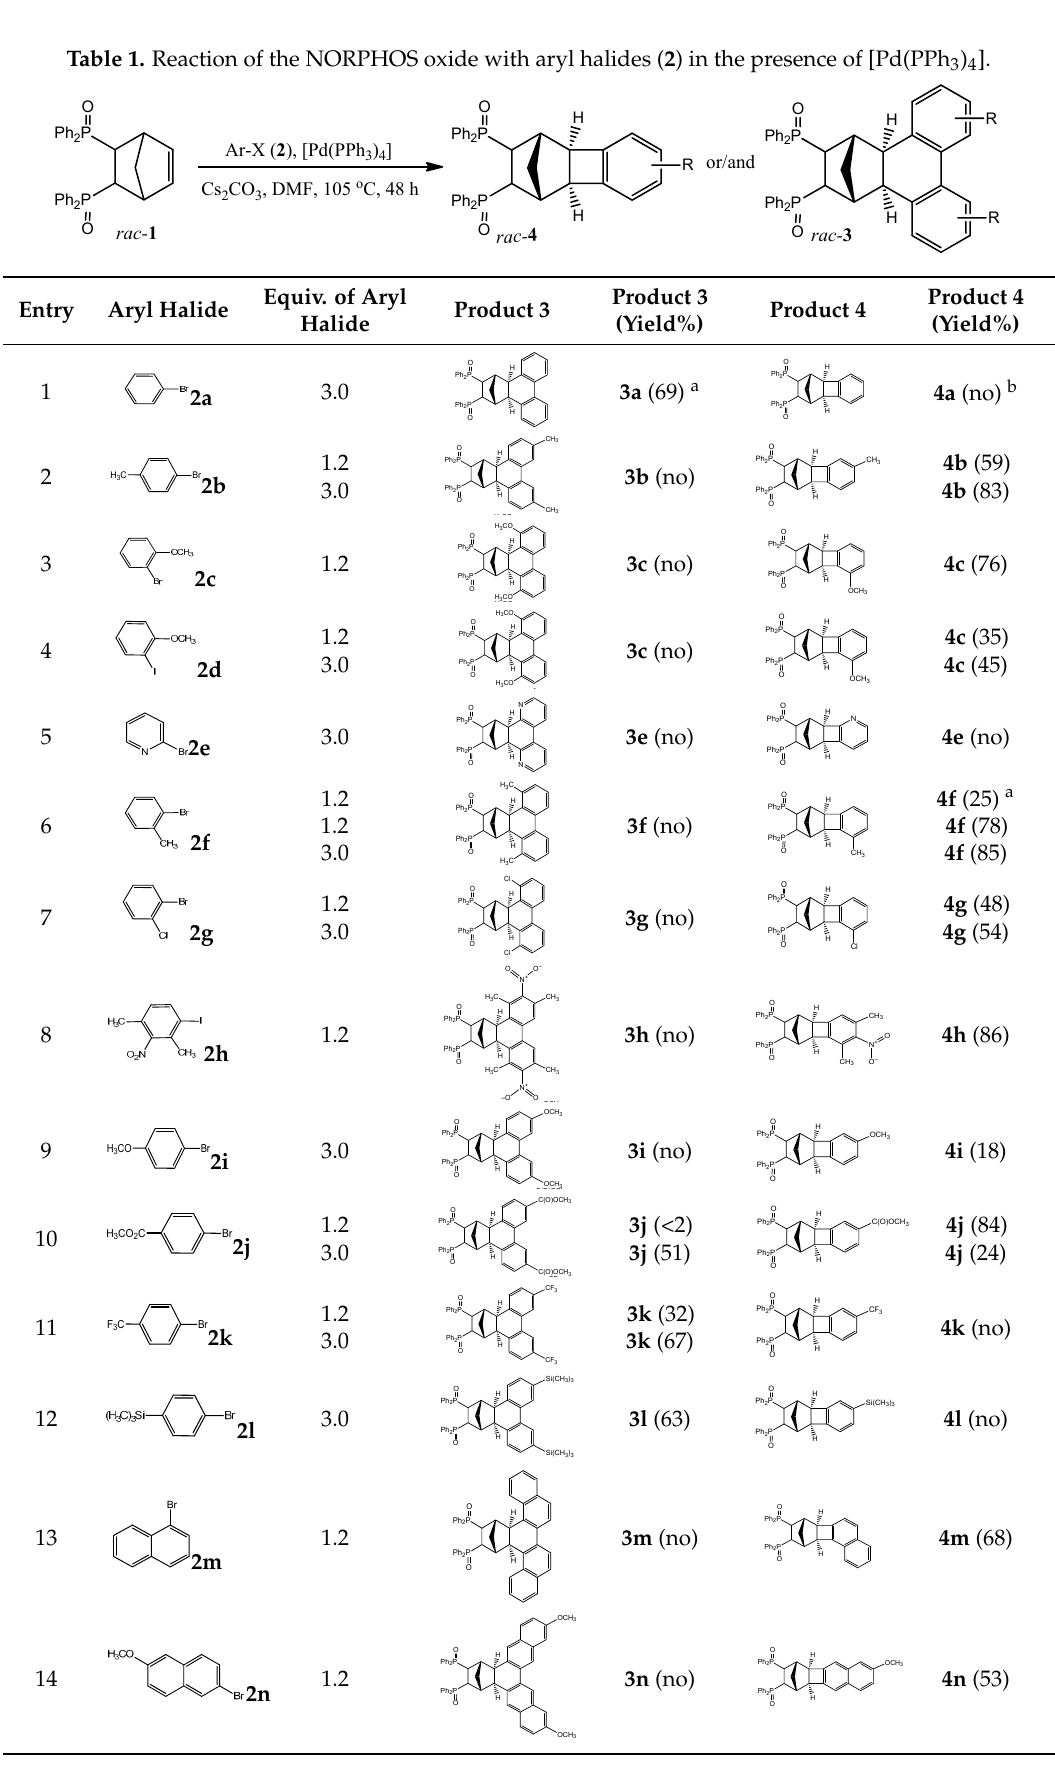
Molecules 2019 , 24 , x Table 1. Reaction of the NORPHOS oxide with aryl halides ( 2 ) in the presence of [Pd(PPh 3 ) 4 ]. Table 1. Reaction of the NORPHOS oxide with aryl halides ( 2 ) in the presence of [Pd(PPh 3 ) 4 ]. Table 1. Reaction of the NORPHOS oxide with aryl halides ( 2 ) in the presence of [Pd(PPh 3 ) 4 ]. Table 1. Reaction of the NORPHOS oxide with aryl halides ( 2 ) in the presence of [Pd(PPh 3 ) 4 ]. Table 1. Reaction of the NORPHOS oxide with aryl halides ( 2 ) in the presence of [Pd(PPh 3 ) 4 ]. Table 1. Reaction of the NORPHOS oxide with aryl halides ( 2 ) in the presence of [Pd(PPh 3 ) 4 ]. Table 1. Reaction of the NORPHOS oxide with aryl halides ( 2 ) in the presence of [Pd(PPh 3 ) 4 ]. Table 1. Reaction of the NORPHOS oxide with aryl halides ( 2 ) in the presence of [Pd(PPh 3 ) 4 ]. Table 1. Reaction of the NORPHOS oxide with aryl halides ( 2 ) in the presence of [Pd(PPh 3 ) 4 ]. Table 1. Reaction of the NORPHOS oxide with aryl halides ( 2 ) in the presence of [Pd(PPh 3 ) 4 ]. Table 1. Reaction of the NORPHOS oxide with aryl halides ( 2 ) in the presence of [Pd(PPh 3 ) 4 ]. Table 1. Reaction of the NORPHOS oxide with aryl halides ( 2 ) in the presence of [Pd(PPh 3 ) 4 ]. Table 1. Reaction of the NORPHOS oxide with aryl halides ( 2 ) in the presence of [Pd(PPh 3 ) 4 ]. Table 1. Reaction of the NORPHOS oxide with aryl halides ( 2 ) in the presence of [Pd(PPh 3 ) 4 ]. Table 1. Reaction of the NORPHOS oxide with aryl halides ( 2 ) in the presence of [Pd(PPh 3 ) 4 ]. Table 1. Reaction of the NORPHOS oxide with aryl halides ( 2 ) in the presence of [Pd(PPh 3 ) 4 ]. Table 1. Reaction of the NORPHOS oxide with aryl halides ( 2 ) in the presence of [Pd(PPh 3 ) 4 ]. Table 1. Reaction of the NORPHOS oxide with aryl halides ( 2 ) in the presence of [Pd(PPh 3 ) 4 ]. Table 1. Reaction of the NORPHOS oxide with aryl halides ( 2 ) in the presence of [Pd(PPh 3 ) 4 ]. Table 1. Reaction of the NORPHOS oxide with aryl halides ( 2 ) in the presence of [Pd(PPh 3 ) 4 ]. Table 1. Reaction of the NORPHOS oxide with aryl halides ( 2 ) in the presence of [Pd(PPh 3 ) 4 ]. Table 1. Reaction of the NORPHOS oxide with aryl halides ( 2 ) in the presence of [Pd(PPh 3 ) 4 ]. Table 1. Reaction of the NORPHOS oxide with aryl halides ( 2 ) in the presence of [Pd(PPh 3 ) 4 ]. Table 1. Reaction of the NORPHOS oxide with aryl halides ( 2 ) in the presence of [Pd(PPh 3 ) 4 ]. Table 1. Reaction of the NORPHOS oxide with aryl halides ( 2 ) in the presence of [Pd(PPh 3 ) 4 ]. Table 1. Reaction of the NORPHOS oxide with aryl halides ( 2 ) in the presence of [Pd(PPh 3 ) 4 ]. Table 1. Reaction of the NORPHOS oxide with aryl halides ( 2 ) in the presence of [Pd(PPh 3 ) 4 ]. Table 1. Reaction of the NORPHOS oxide with aryl halides ( 2 ) in the presence of [Pd(PPh 3 ) 4 ]. Table 1. Reaction of the NORPHOS oxide with aryl halides ( 2 ) in the presence of [Pd(PPh 3 ) 4 ]. Table 1. Reaction of the NORPHOS oxide with aryl halides ( 2 ) in the presence of [Pd(PPh 3 ) 4 ]. Table 1. Reaction of the NORPHOS oxide with aryl halides ( 2 ) in the presence of [Pd(PPh 3 ) 4 ]. PO PO PO PO Ph 2 P Ph 2 P PO Ph 2 P Ph 2 P Ph 2 P PO Ph 2 P Ph 2 P Ph 2 P Ph 2 P Ph 2 P PO Ph 2 P Ph 2 P Ph 2 P PO PO Ph 2 P Ph 2 P Ph 2 P PO Ph 2 P Ph 2 P Ph 2 P Ph 2 P Ph 2 P Ph 2 P Ph 2 P Ph 2 P Ph 2 P Ph 2 P Ph 2 P Ph 2 P Ph 2 Ph 2 Ph 2 Ph 2 P Ph 2 P Ph 2 Ph 2 Ph 2 Ph 2 Ph 2 Ph 2 Ph 2 Ph 2 Ph 2 Ph 2 Ph 2 Ph 2 Ph 2 Ph 2 O rac- 1 O rac- 1 Ph 2 Ph 2 O rac- 1 Ph 2 Ph 2 Ph 2 Ph 2 Ph 2 O rac- 1 O rac- 1 O rac- 1 O rac- 1 Entry Entry